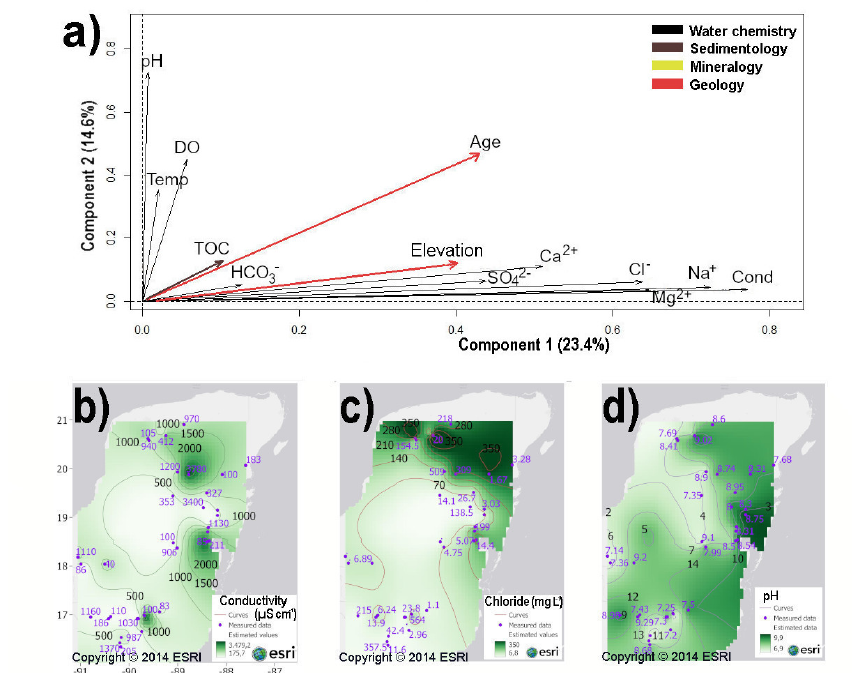
Figure 3. (a) PCA biplot based on 13 variables from 45 aquatic ecosystems of the Yucatán Peninsula and northern Guatemala (YG limnolog- ical region). Conductivity and related ions were the most meaningful variables characterizing aquatic ecosystems as they explain 23.4% of the total variance. The second most important variable is pH, accounting for 14.6% of the total variance. Arrows represent variables. Spatial representations of meaningful variables are presented in (b–d) interpolated maps of conductivity (b) ; chloride (c) ; pH (d) . Abbreviations are as follows: temperature (temp) ( ◦ C), conductivity (cond) (µScm − 1 ), magnesium (Mg 2 + ), chloride (Cl − ), bicarbonate (HCO 3 − ), potassium (K + ), calcium (Ca 2 + ), sodium (Na + ), sulfates (SO 42 − ) dissolved oxygen (DO) (µmolL − 1 ) and total organic carbon (TOC). Major ions concentrations are expressed in mgL − 1 . Blue numbers in maps represent measured values, black numbers are interpolated